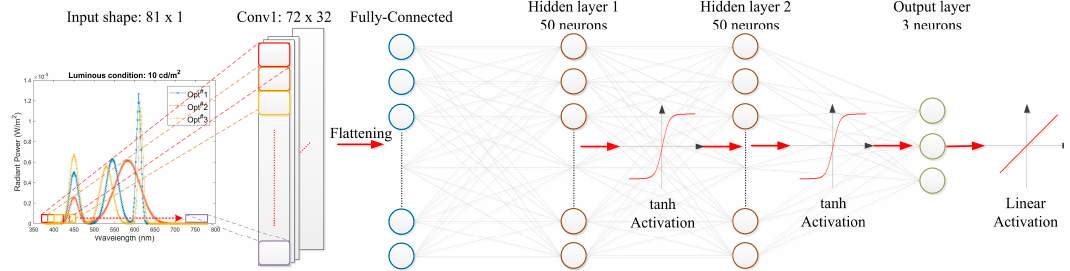
Figure 9. Architecture of the evaluation model.